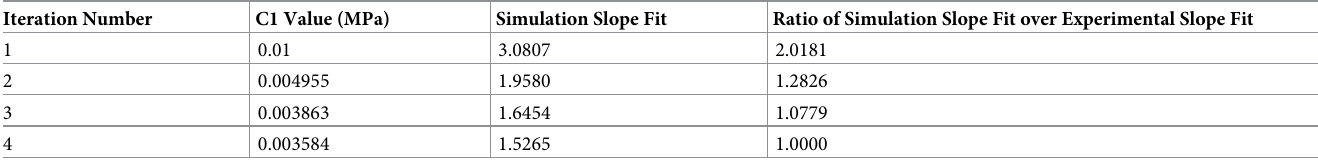
Table 5. Inverse FEA results to calibrate the female upper arm model overview. upper arm listed in Table 5. The data portion of the repository contains the FEBio text file out- put for each iteration, listed as a separate run from 1 to 4 for this model. Only the Postview files (.xplt) for the first and last simulation runs are uploaded, representing the literature prop- erties and converged material properties respectively. The Postview files are not a match of the experimental conditions, due to the cropping method utilized and described above. The initial guess of a 0.06 MPa effective Young’s modulus was stiffer than the tissue was in experimentation in seven of the eight models (Fig 5). Only the male upper leg was stiffer, with an effective modulus of 0.0686 MPa (Table 4). The extremities of the male donor had a higher effective modulus on average than the female, at 0.0437 MPa against 0.0312 MPa. The upper arm and lower leg regions had similar effective moduli across the subjects, with the discrep- ancy between the two donors lying in the lower arm and upper leg. The mean effective modu- lus for the leg regions were nearly 2.5 times stiffer than the arm regions, with a mean modulus of 0.534 MPa to 0.0214 MPa.